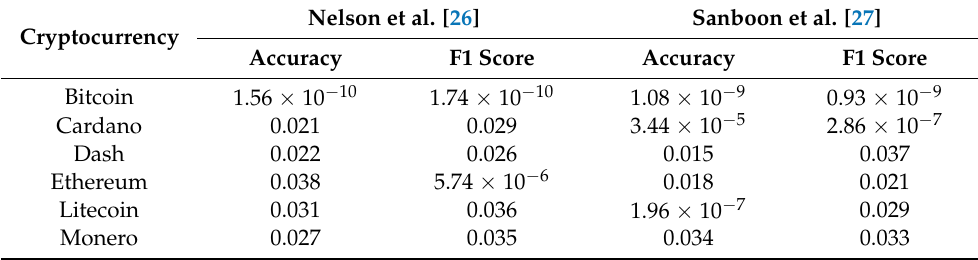
Table 8. Value of the t -test in each cryptocurrency’s accuracy and the F1 score. Nelson et al. Cryptocurrency